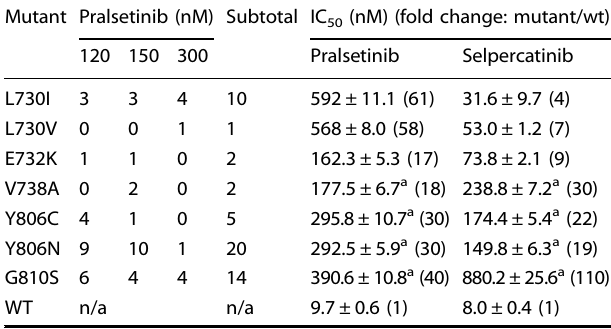
Table 1. Identi fi cation and characterization of pralsetinib-resistant RET